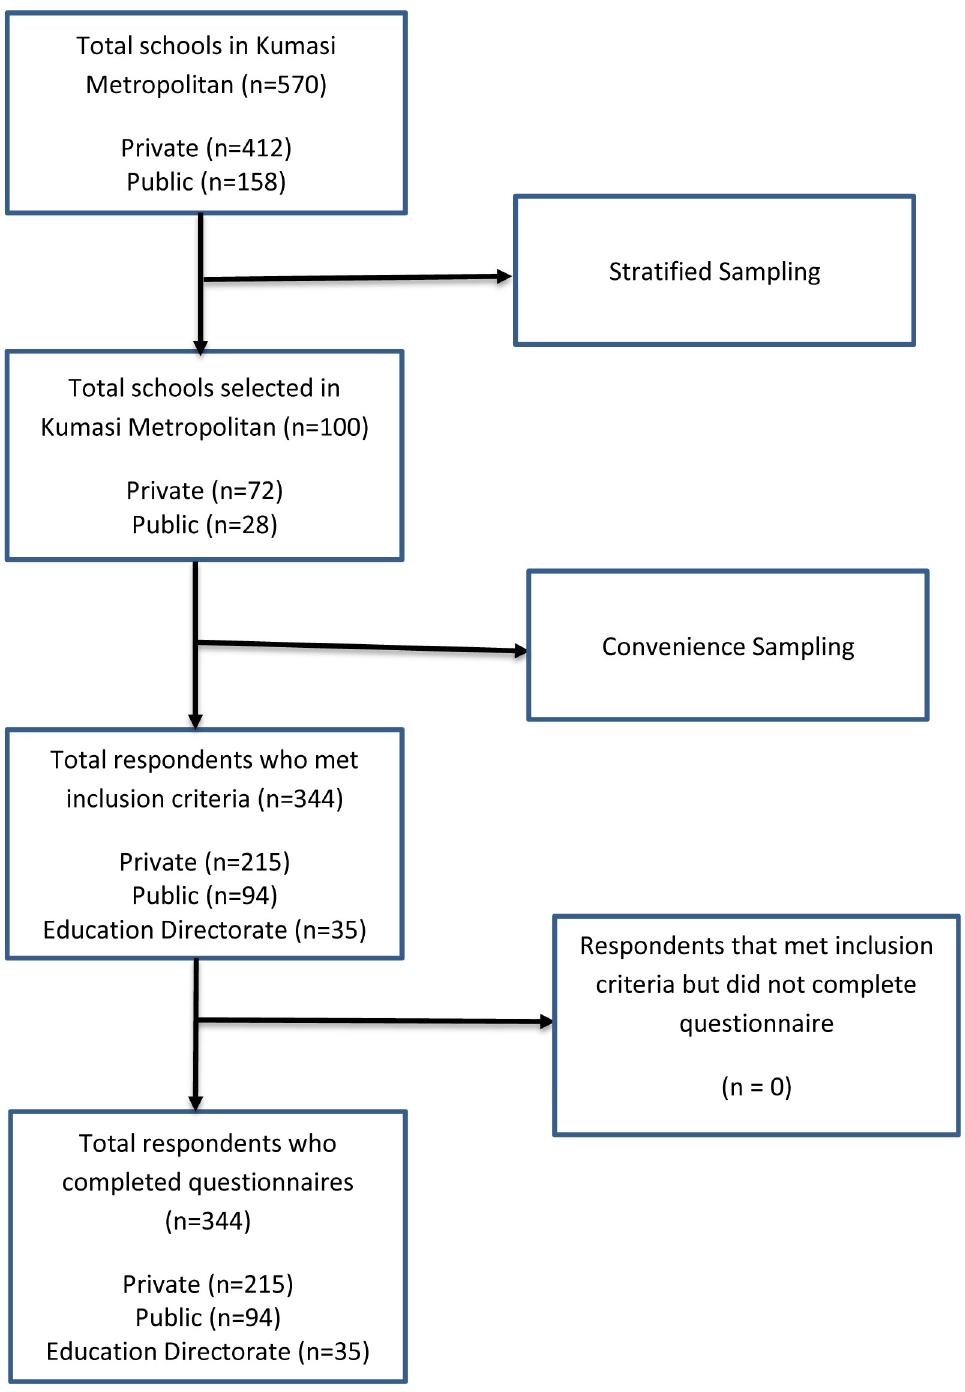
Fig 1. Flowchart showing the flow of participants through the research